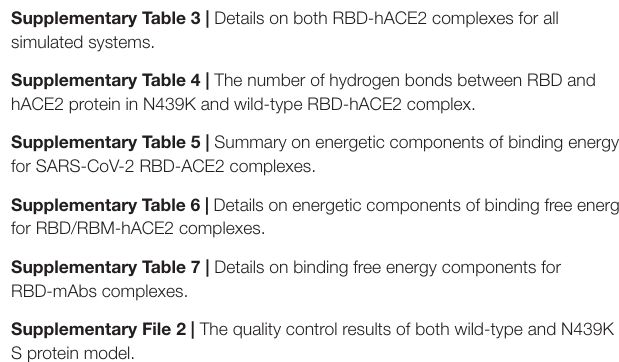
Supplementary Table 1 | Statistics of the mutations of SARS-CoV-2 from GISAID database. Supplementary Table 3 | Details on both RBD-hACE2 complexes for all simulated